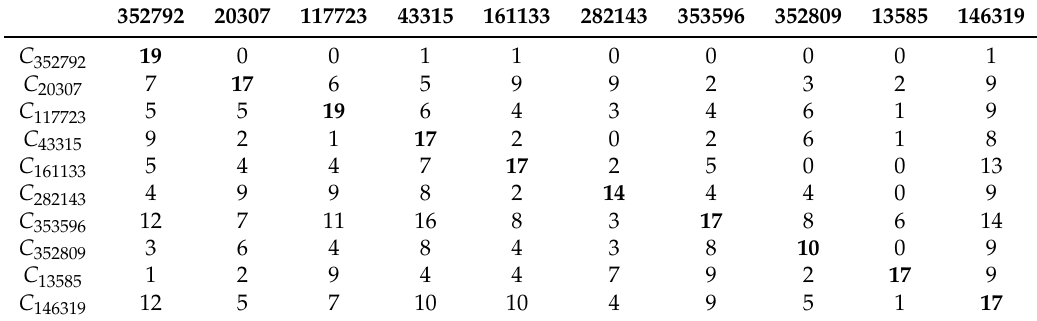
Table 3. Example of a confusion matrix for Experiment 1. Columns correspond to users and rows to classifiers. Each cell M ( i , j ) contains the number of posts (out of 20) for which classifier C i answered yes for a post actually authored by user u j . The diagonal is highlighted in